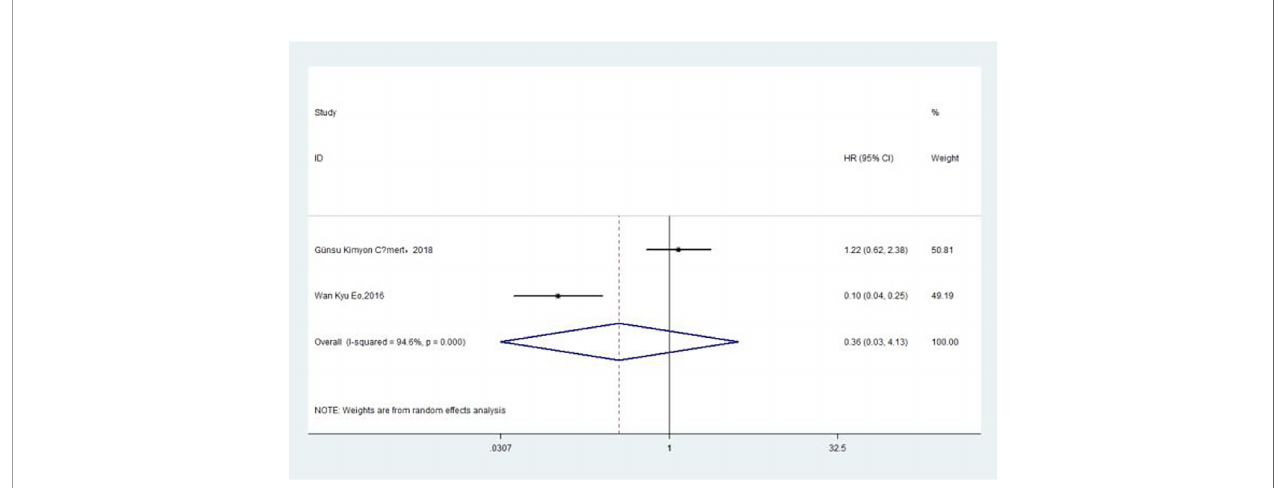
FIGURE 8 | Relationship between monocyte – lymphocyte ratio and disease-free survival in univariate